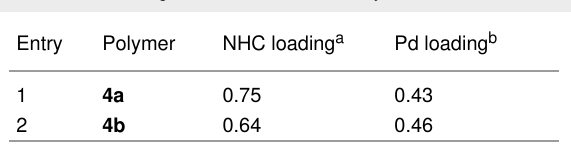
Table 1: Pd Loading for the different NHC-Pd